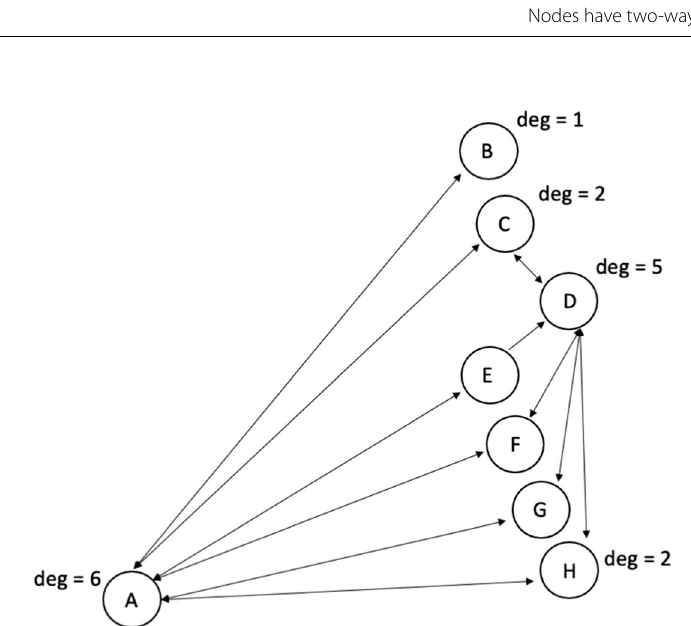
Fig. 5 Example SCADA network nodes with corresponding degree